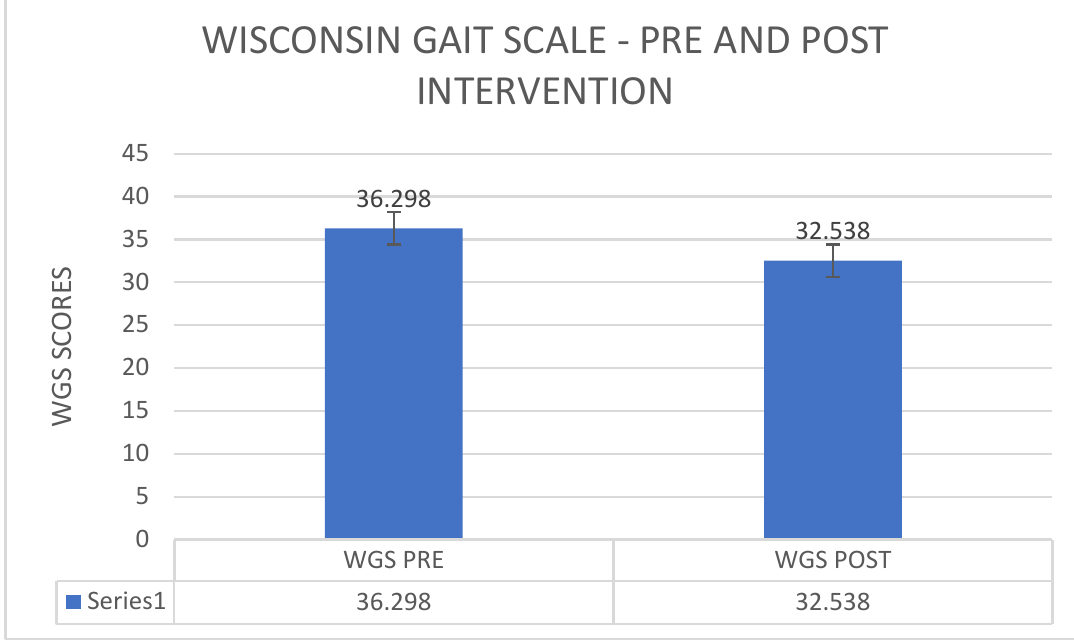
Figure 4. Pre–post comparison of Wisconsin gait scale.